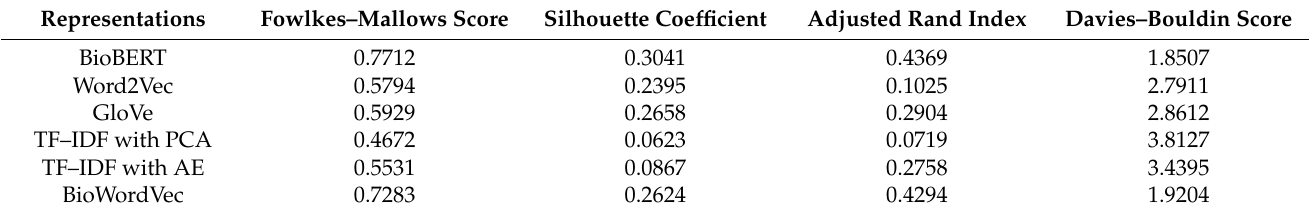
Table 4. Evaluation results of k-means clustering for biomedical documents.